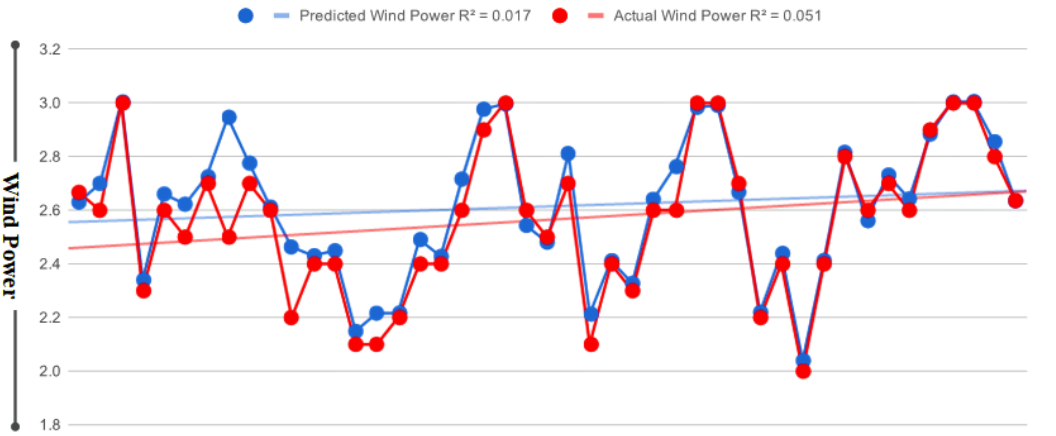
Figure 5. Forecasted and Actual Power (kW) outcomes for Windfarm 1 via the Proposed Methodology.